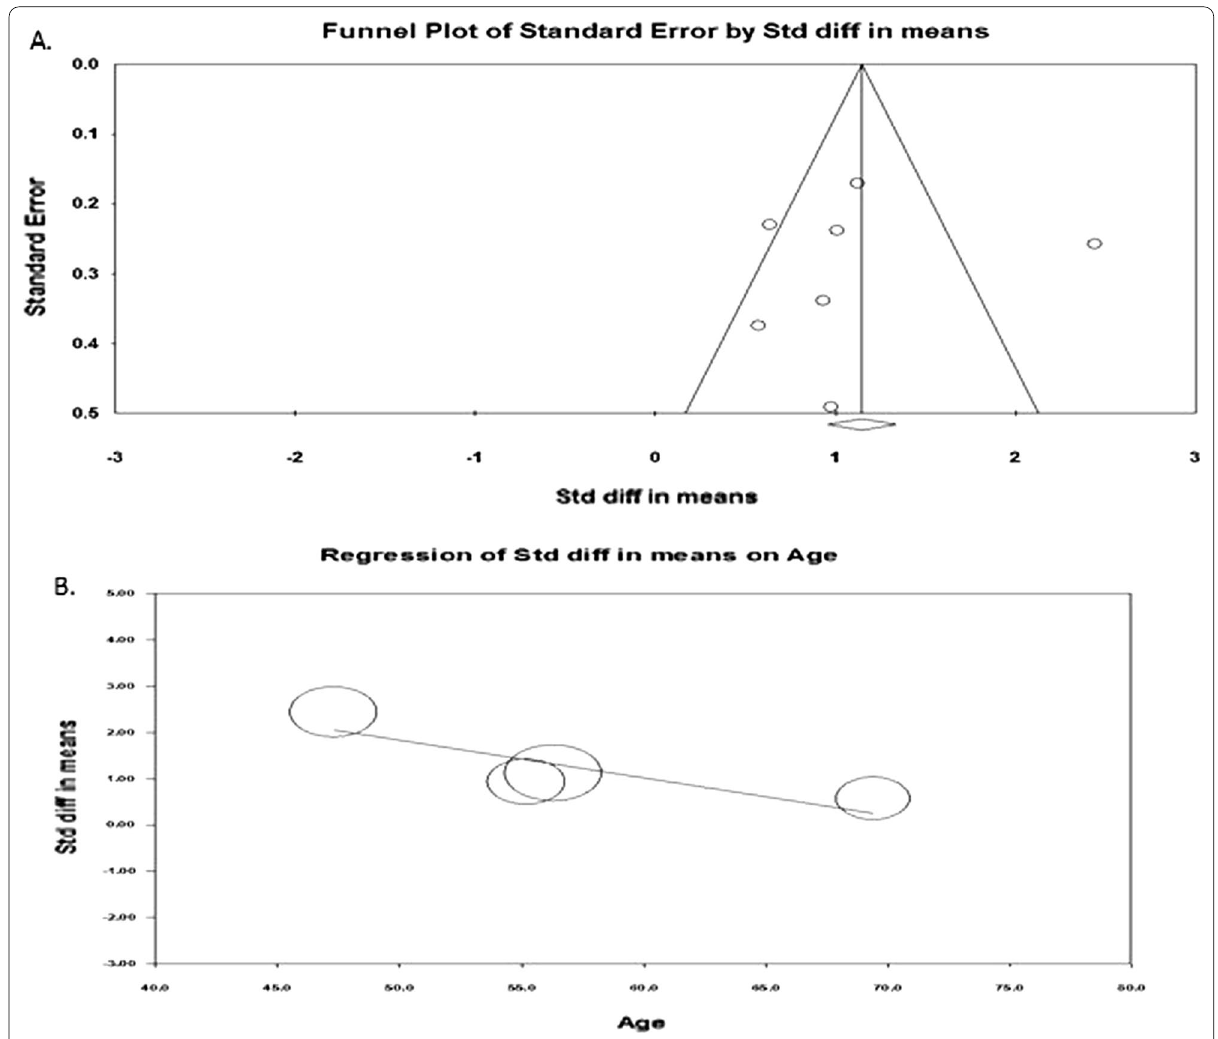
Fig. 6 Publcation biasl ( A ) and regressin analysis ( B ) of effect size on age